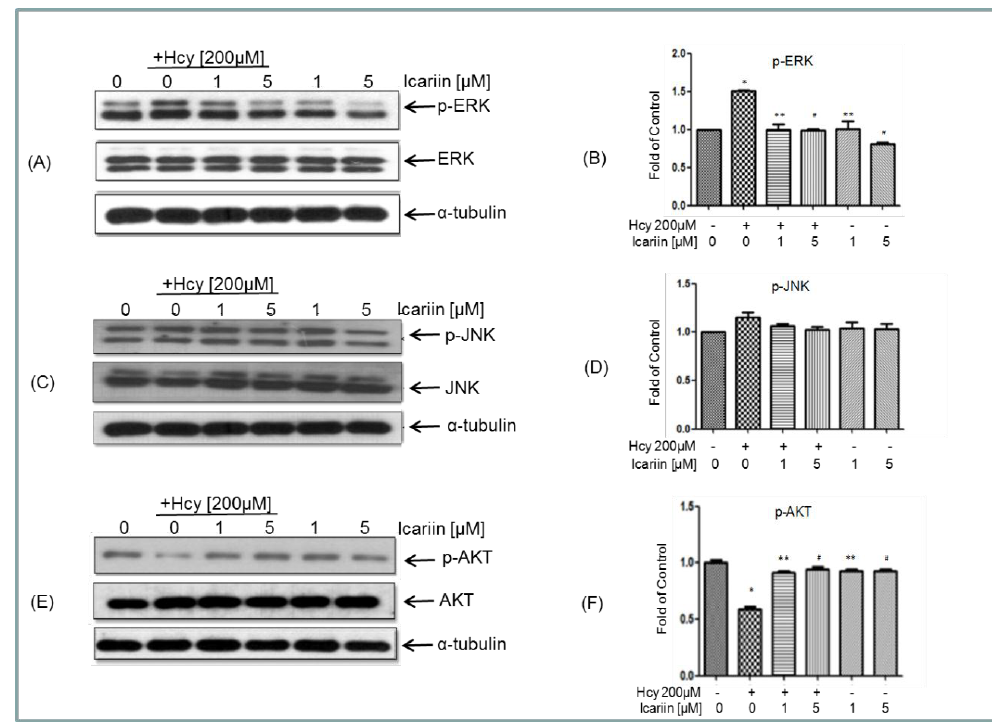
Figure 5. Icariin counteracts the effects of Hcy on ERK ( A , B ), JNK ( C , D ) and AKT ( E , F ) signaling molecules assessed using the western blot analysis. Cells were treated with either Hcy, Icariin, or both according to the treatment illustrated in Figure 3 legend. The α-tubulin was used as internal control. Statistical analysis was performed with one-way ANOVA. *: p < 0.05 compared to control. # and **: p < 0.05 compared to cultures treated with Hcy (200 μM). Data represent mean ± SE from at least 3 independent experiments. “+” and “-”: with and without the compound.